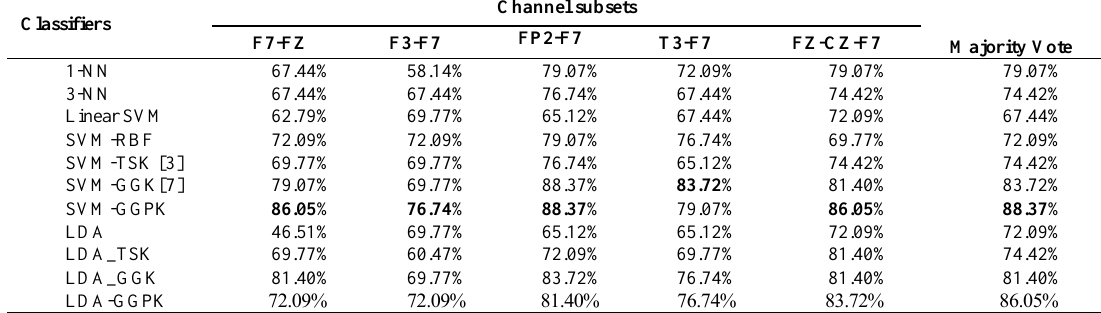
Table 2. Accuracy of different classifiers (1-NN, 3-NN, linear SVM, SVM with RBF, TSK, GGPK, and GGK kernels) on different subsets of EEG signals of ADHD and BMD patients at eyes-closed resting